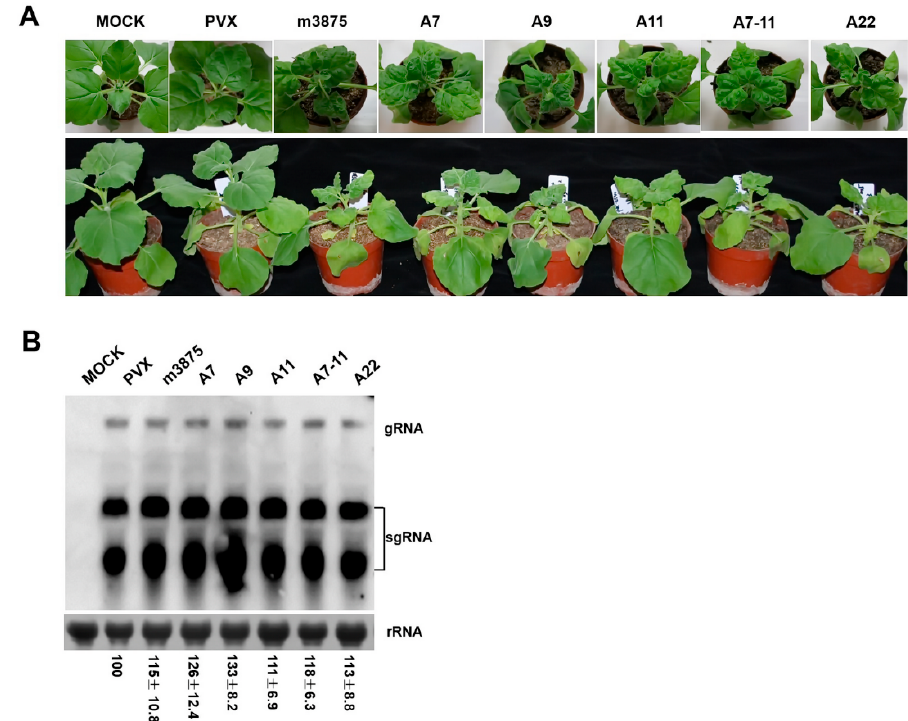
Figure 5. Characteristics of the PVX-m3875 hybrids in systemically infected Nicotiana benthamiana at 15 days post inoculation (dpi). ( A ) Systemic symptoms of PVX, PVX-m3875, PVX-A7, PVX-A9, PVX-A11, PVX-A7-11 and PVX-A22. The PVX-infected N. benthamiana plants showed little difference compared with the mock-inoculated N. benthamiana, while the plants infected with the PVX vector expressing m3875 or the mutants developed dwarfing as well as leaf deformation and mosaic. ( B ) Northern blot analysis of PVX RNA. Total RNA was extracted from the upper systemically infected leaves of a similar developmental stage. Bands that corresponded to the PVX viral RNAs are indicated, and rRNA stained with methylene blue is shown as a loading control. Numbers represent the means with the standard deviation (SD), indicating the relative abundance of the gRNA normalized to that of PVX. The experiment was repeated three times with similar results.